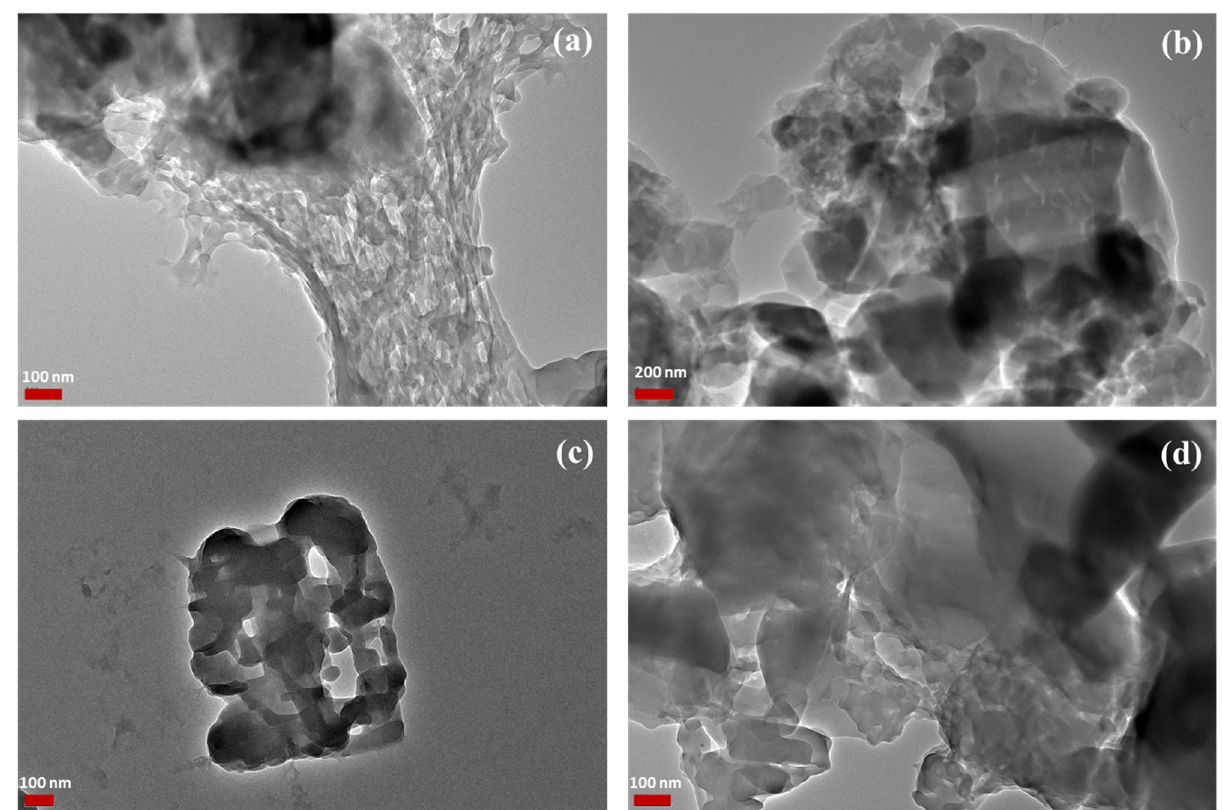
Figure 7. TEM images of ( a , b ) the poly (ester amide) based on L-arginine and ( c , d ) TQ-loaded nanoparticles. Scales: ( a ) 100 nm, ( b ) 200 nm, ( c ) 100 nm, and ( d ) 100nm.